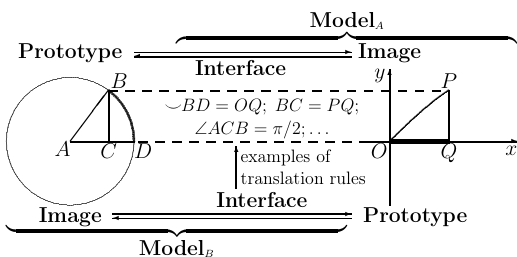
Figure 9. Illustration for the concept of